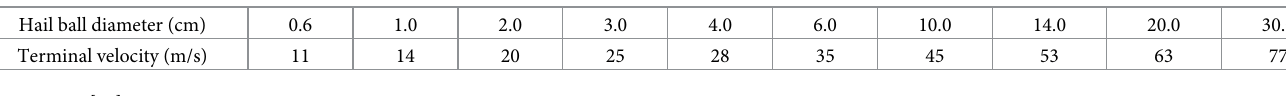
Table 1. Relationship of hail ball diameter and terminal